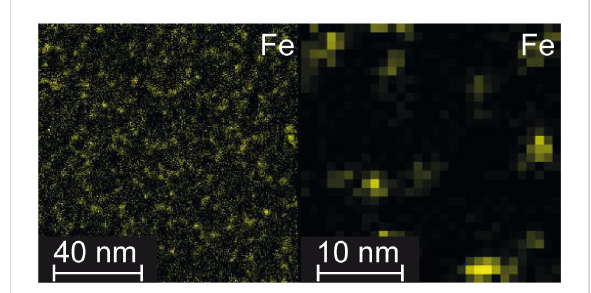
Figure 1: EFTEM (left) and STEM (right) micrographs of a 10 vol % Fe 1000 /Cr sample prepared on a TEM grid + amorphous carbon film with an Fe cluster equivalent thickness of 0.2 nm. The EFTEM image shows the Fe cluster distribution in the sample and the STEM image individual Fe clusters, it was recorded using EDX and the Fe K